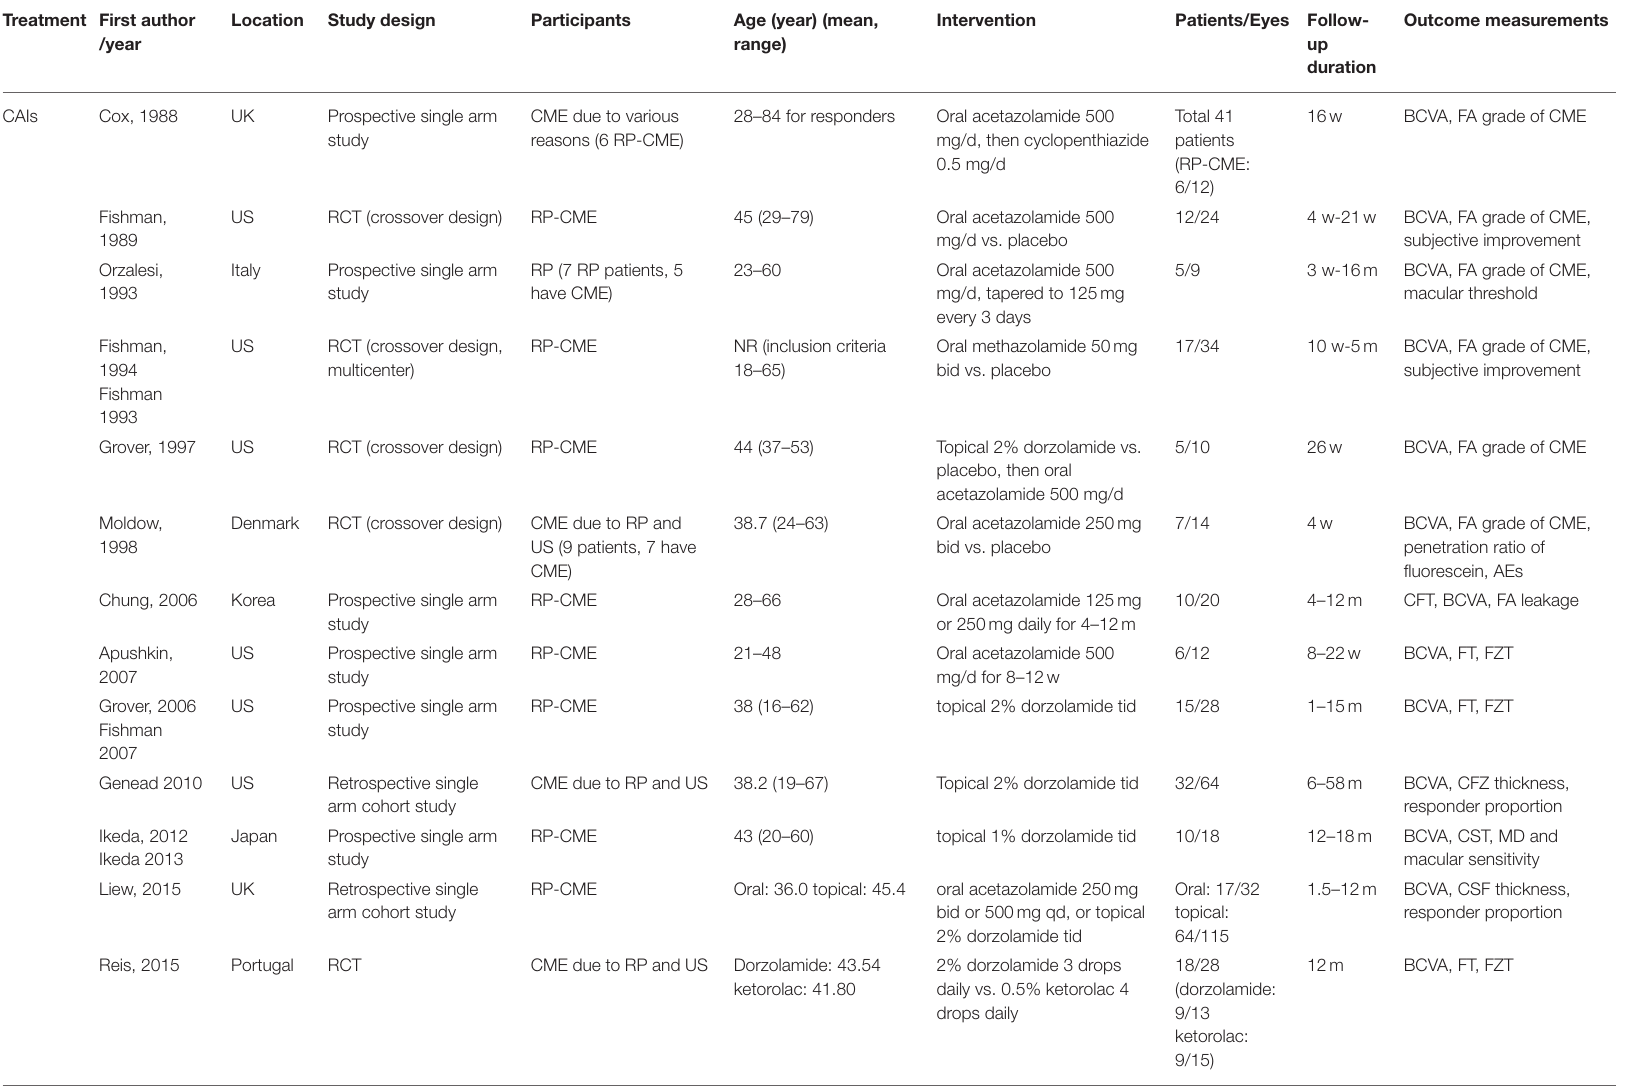
TABLE 1 | Characteristics of included